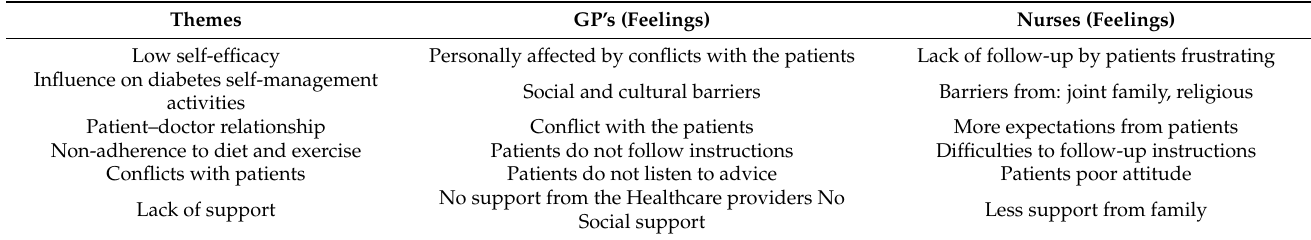
Figure 3. Themes from healthcare professionals’ perspectives of patients’ experiences of self-management of type 2 diabetes. Table 2. The summary of six major themes from data analysis.